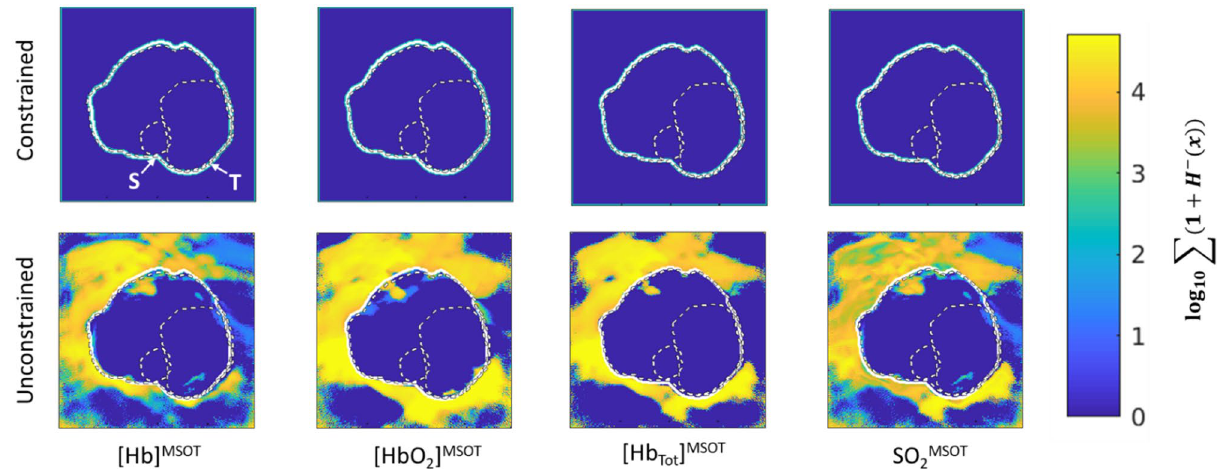
Figure 7. Total occurrence of negative pixels in each channel for the constrained and unconstrained analyses on Dataset A. Animal outline shown, S: Spine, T: Tumor. The constrained analysis results in no negative pixels at any point throughout the imaging time course, reflecting the consistent preservation of the non- negative constraint. The unconstrained analysis, by contrast, develops a large number of negative pixels, including numerous regions within the animal. Figure created using a combination of MATLAB and Microsoft